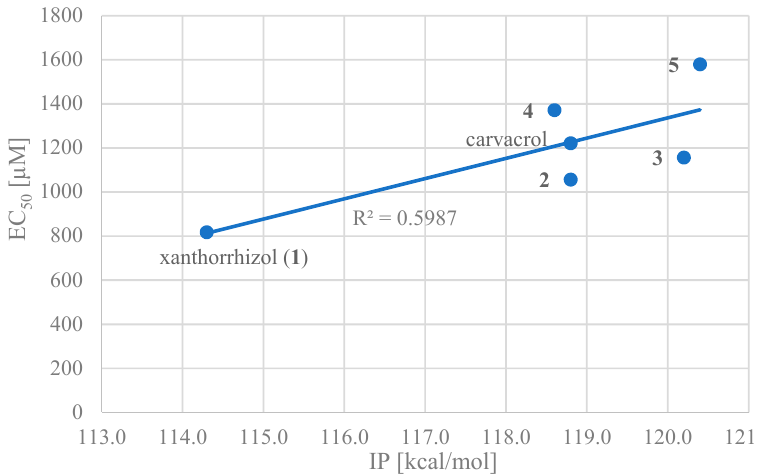
Figure 2. Half-maximal effective concentration (EC 50 ) vs. ionisation potential (IP) (compounds 1 – 5 and carvacrol).